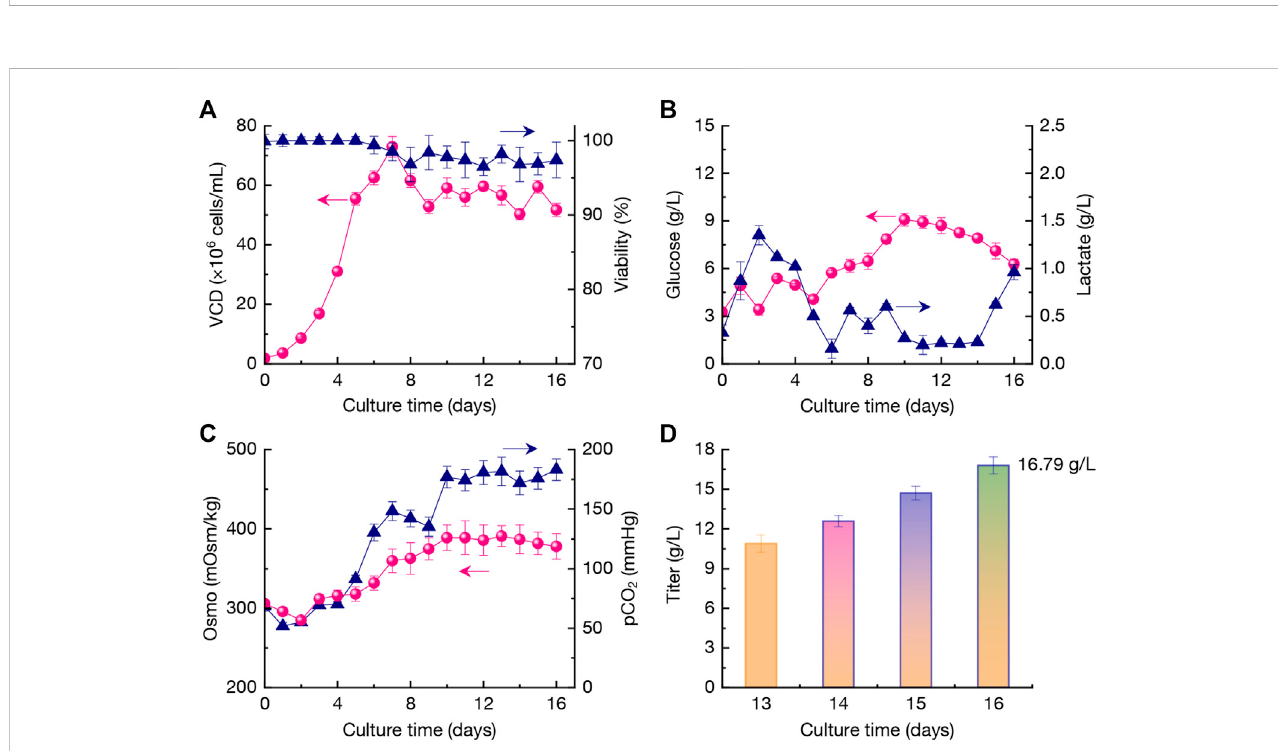
Changingpro fi lesofVCDandviability (A) ,glucoseandlactateconcentration (B) ,OsmoandpCO 2 (C) ,andtiter (D) duringtheoptimizedperfusionculture in a 200-L bioreactor. The error bars indicate the SD of three independent